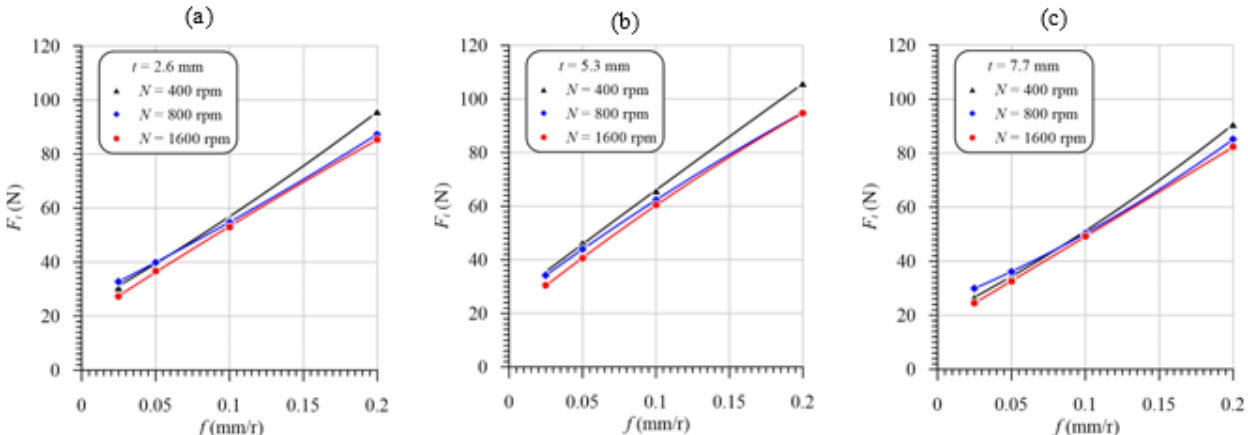
Figure 10. Thrust force vs. feed at different speeds and laminate thicknesses of ( a ) 2.6 mm, ( b ) 5.3 mm, and ( c ) 7.7 mm.